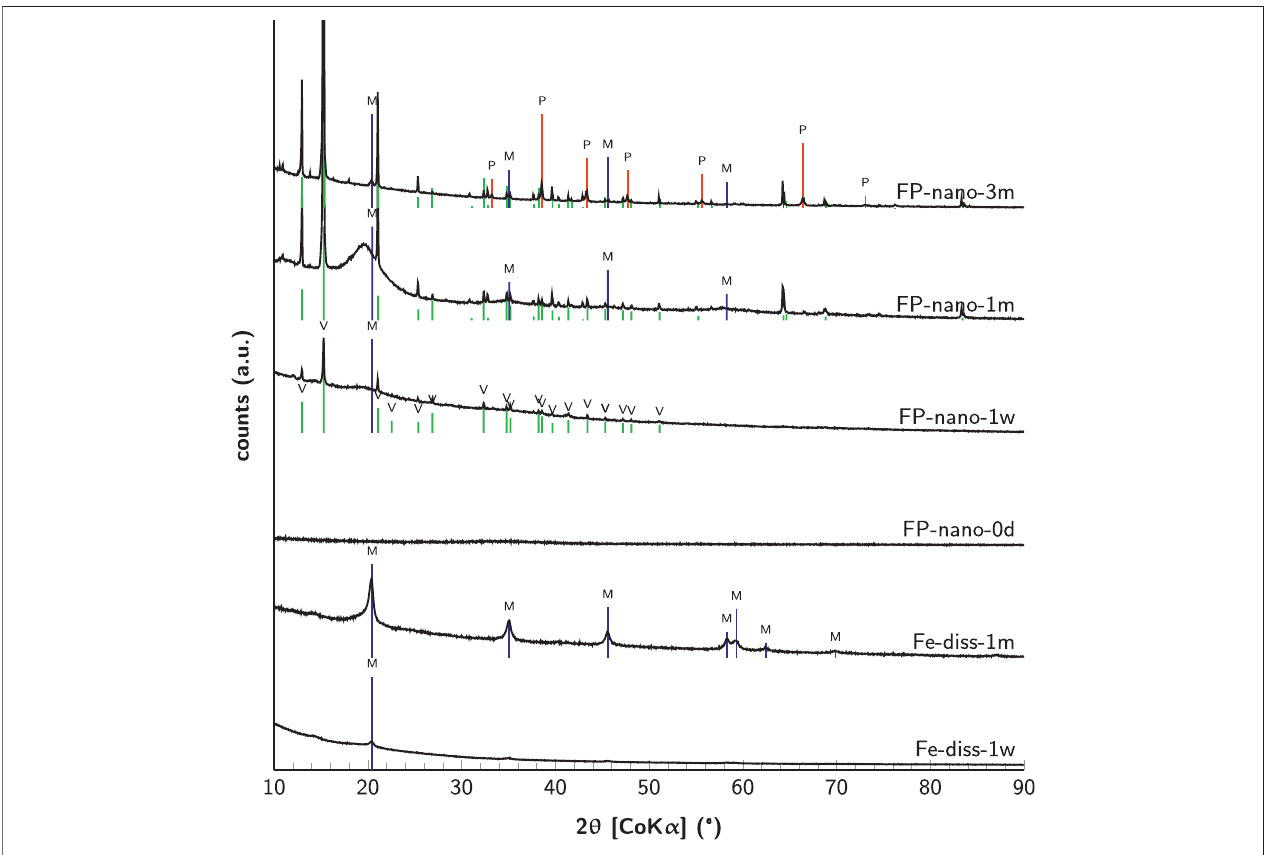
FIGURE2| X-raydiffractogramsofsolidphases incultures after1 week,1month,and 3monthsaswellasofinitialnanoparticulateFe III -phosphate.Characteristic peaks of reference minerals are indexed for mackinawite (blue), vivianite (green), and pyrite (red).